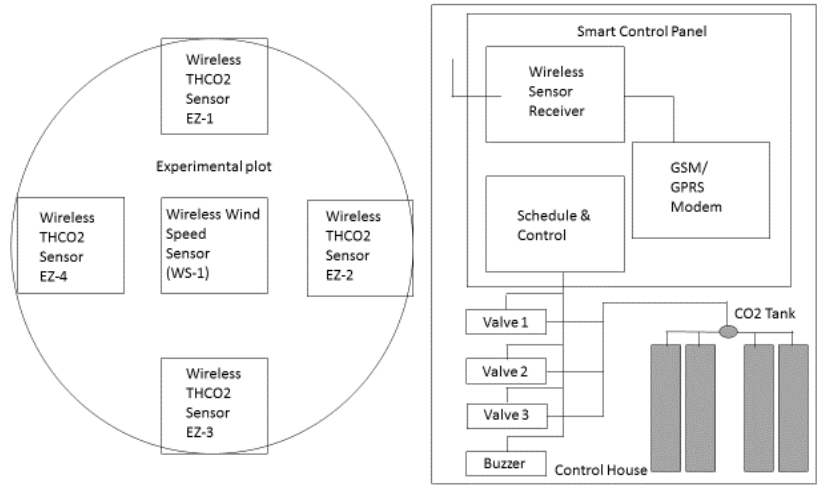
Figure 2. System block of the sensors and working diagram of the FACE.